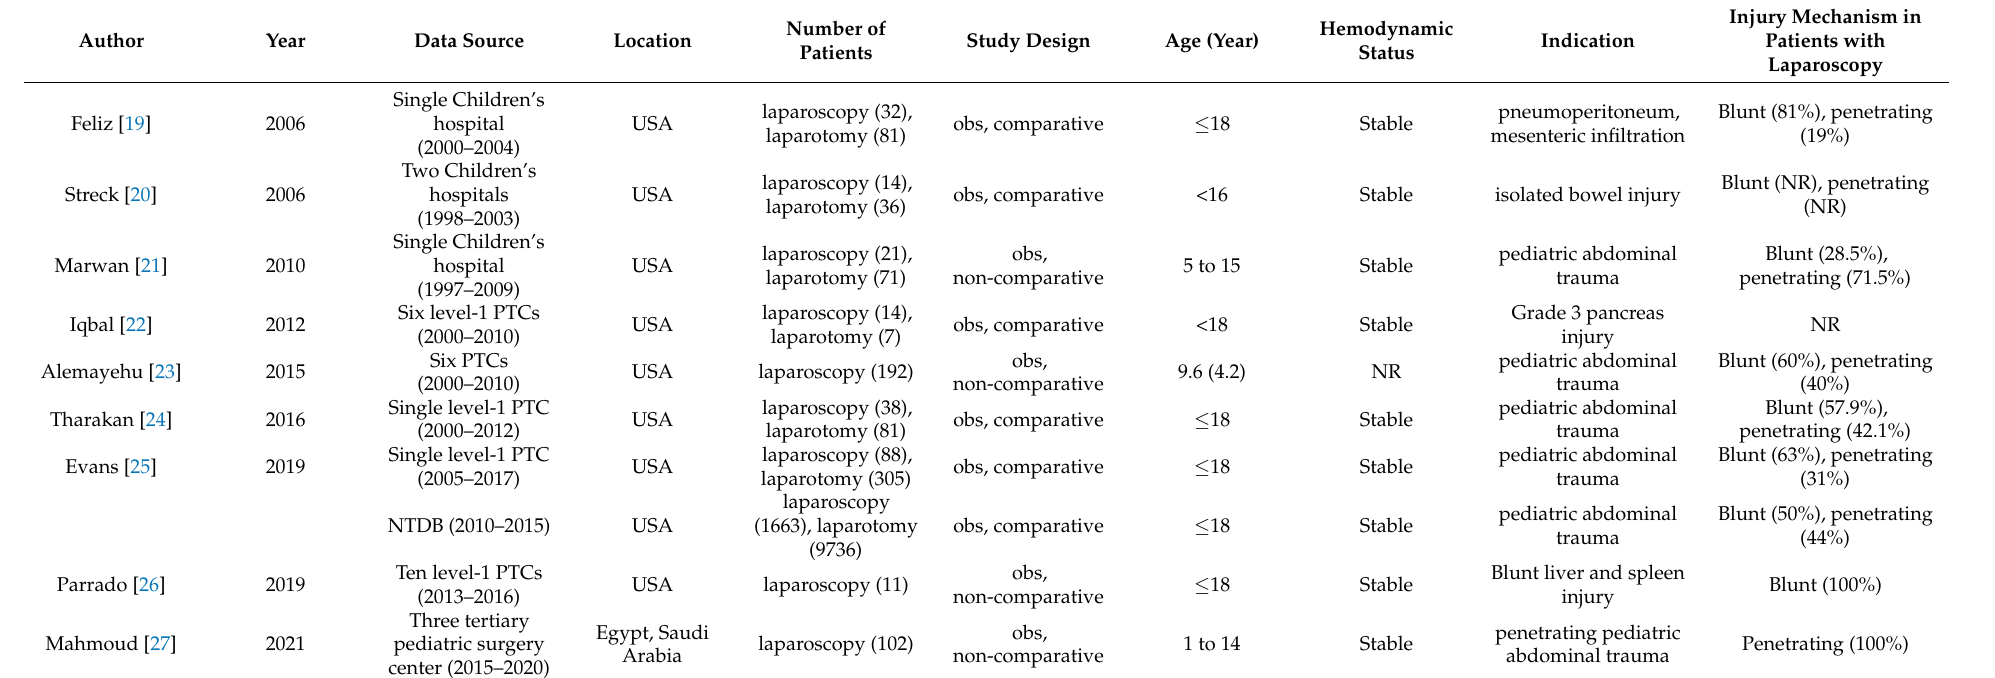
Table 1. Main characteristics of the eligible